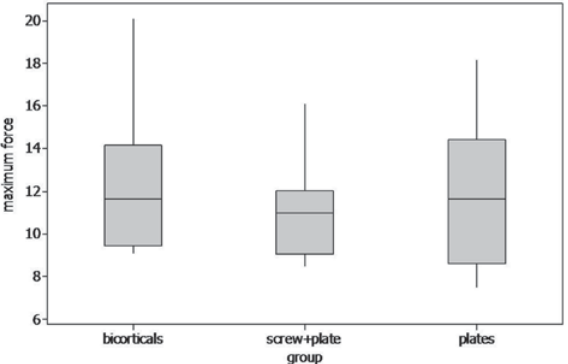
Figure 9- “Boxplot” graphic regarding displacement Groups I (Inverted “L”), II (Hybrid) and III (Plates), respectively